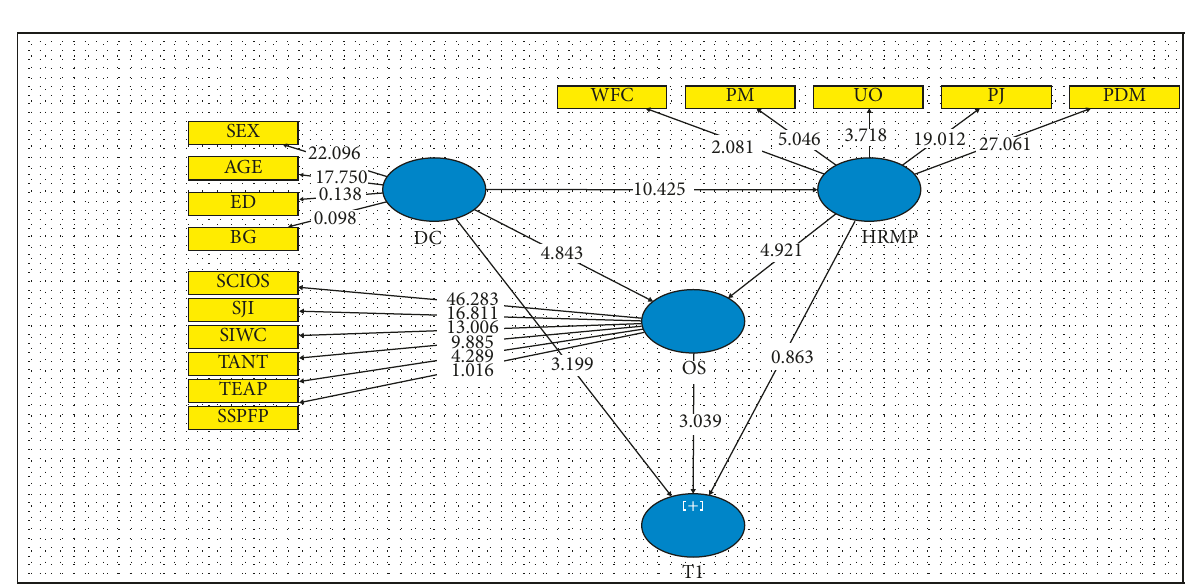
Figure 3: t-Test results. Table 4: Summary of the results of the hypothesis